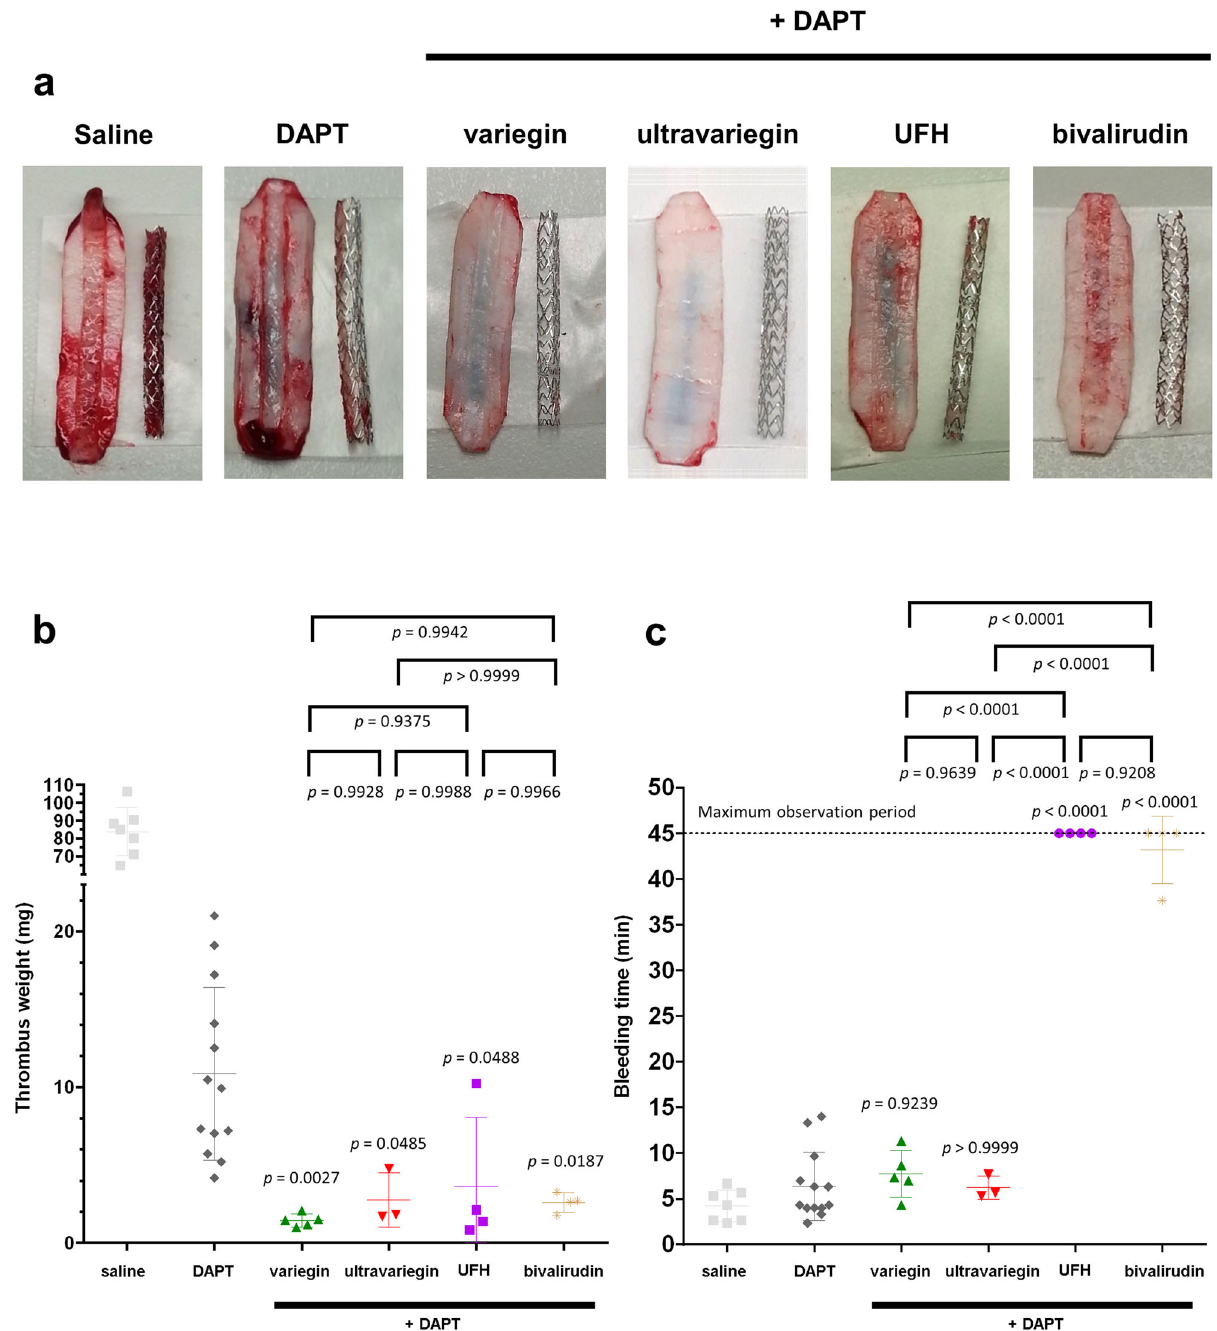
Fig. 6 Ef fi cacy-safety pro fi les of anticoagulants (with DAPT) in porcine models. Ef fi cacy and safety were determined using ex vivo stent thrombosis and super fi cial ear vein bleeding models, respectively. All pigs were administered 300 mg aspirin and 180 mg ticagrelor orally (DAPT regimen) 16 h prior to the experiments. a Representative photographs showing thrombi formed on coronary stents and endothelium-denuded pig aorta strips in pigs administered with DAPT only ( n = 13), DAPT with 0.1 mg/kg variegin (i.v. bolus, n = 5), DAPT with 0.025 mg/kg ultravariegin (i.v. bolus, n = 3), DAPT with 100 u/kg UFH (i.v. bolus, n = 4), and DAPT with 0.75 mg/kg (i.v. bolus) plus 1.75 mg/kg/h (i.v. continuous infusion) bivalirudin ( n = 4). Photograph from a pig receiving saline without DAPT, as depicted in Fig. 5a, is reproduced here for comparison. Experiments were repeated the indicated n number of animals independently with similar results. b Total weight of thrombi (one-way ANOVA P = 0.0007). c Bleeding time (one-way ANOVA P < 0.0001). Multiplicity- adjusted P values for post hoc Tukey ’ s multiple comparisons between respective anticoagulants with DAPT are indicated immediately above each treatment. Multiple comparison among anticoagulants were indicated on top of the plot. Data shown are mean ± SD.